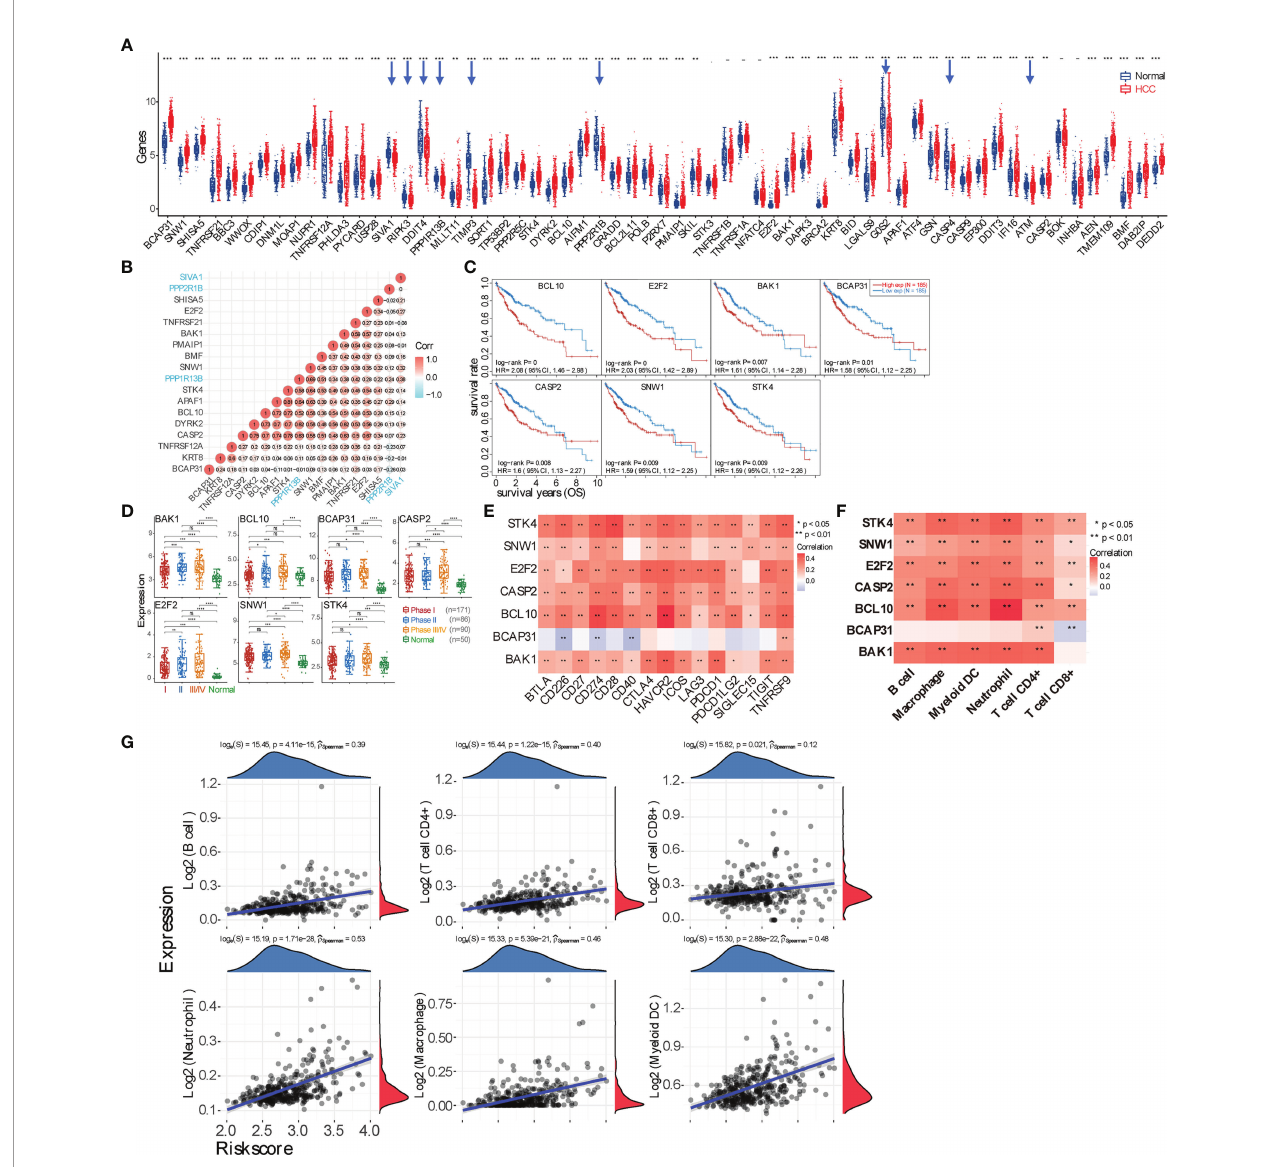
FIGURE 2 | Evaluating the underlying correlation between apoptosis and immune microenvironment. (A) Expression spectrum of apoptosis marker genes in hepatocellular carcinoma (HCC) tumor tissue. Downregulated genes are highlighted by blue arrows. (B) Multi-gene correlation map generated using the genes with signi fi cant (p < 0.05) correlation with the overall survival (OS) rate. A positive value represents a positive correlation; otherwise, a negative correlation. The larger correlation value means the better correlation between two genes. The three genes labeled with blue color are downregulated genes in panel (A, C) Survival curves of 7 genes (BCL10, E2F2, BAK1, BCAP31, CASP2, SNW1, and STK4) that negatively correlate with prognosis (p < 0.01). (D) Expression difference of those 7 genes in HCC tumor tissues among patients with stage I, II, or III – IV. (E) Correlation analysis between 7 marker genes and checkpoint molecules. Only BCAP31 negatively correlates with checkpoint molecules. (F) Correlation between 7 marker genes and major types of immune cell in fi ltration. (G) Spearman ’ s correlation analysis between the risk score of the prognostic model (calculated from the 7 marker genes) and immune score (based on TIMER). The horizontal axis represents the risk score of the prognostic model; the vertical axis represents the immune score. The density curve (red) on the right represents the distribution trend of the immune score, and the dark-blue density curve on the top represents the distribution trend of the risk score. The p-value and correlation coef fi cient ( ^ pSpearman) are shown at the top of the respective graph. *p < 0.05; **p < 0.01; ***p < 0.001; ****p < 0.0001; ‘ - ’ , ns, no statistical signi fi